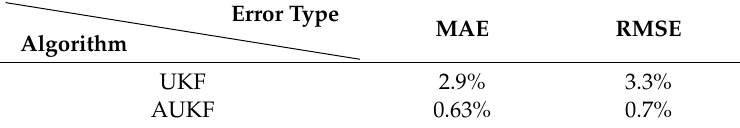
Table 5. Terminal voltage error.